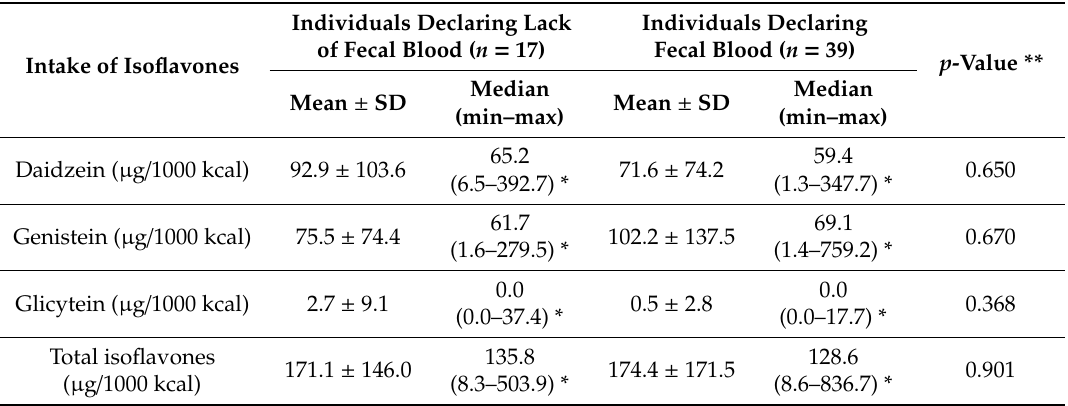
Table 3. The isoflavone intakes per 1000 kcal in groups of individuals with ulcerative colitis declaring either lack or presence of fecal